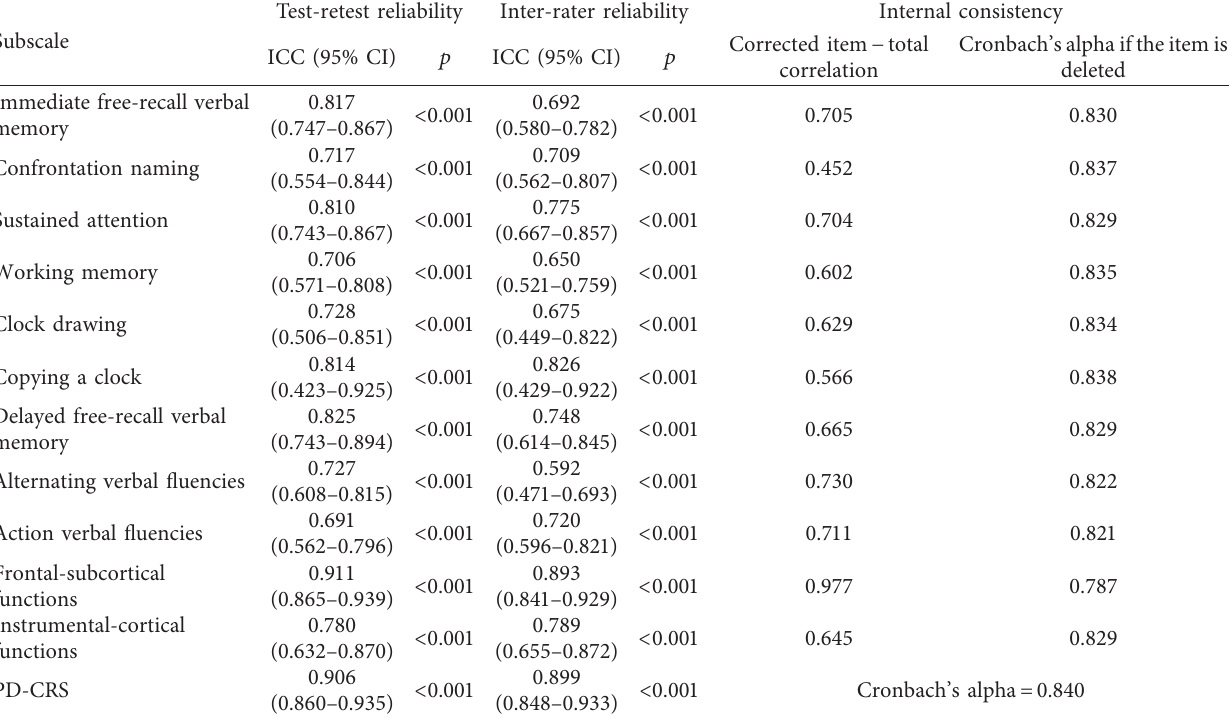
Table 2: Reliability and internal consistency for both total and individual item scores of PD-CRS.